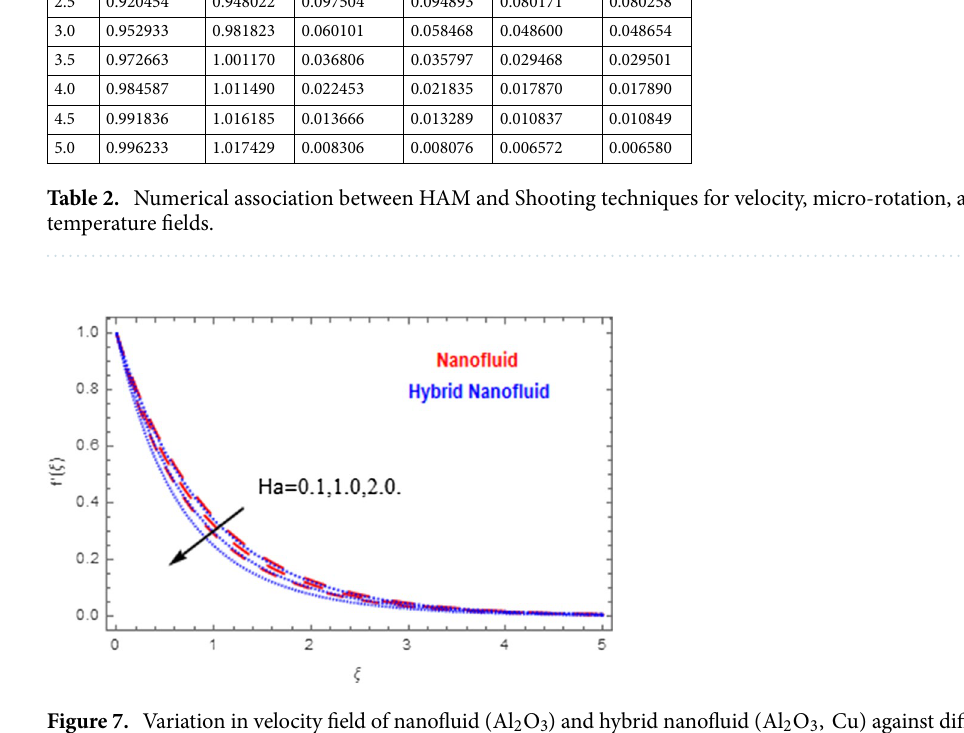
Figure 7. Variation in velocity field of nanofluid ( Al 2 O 3 ) and hybrid nanofluid ( Al 2 O 3 , Cu ) against different estimations of Ha .